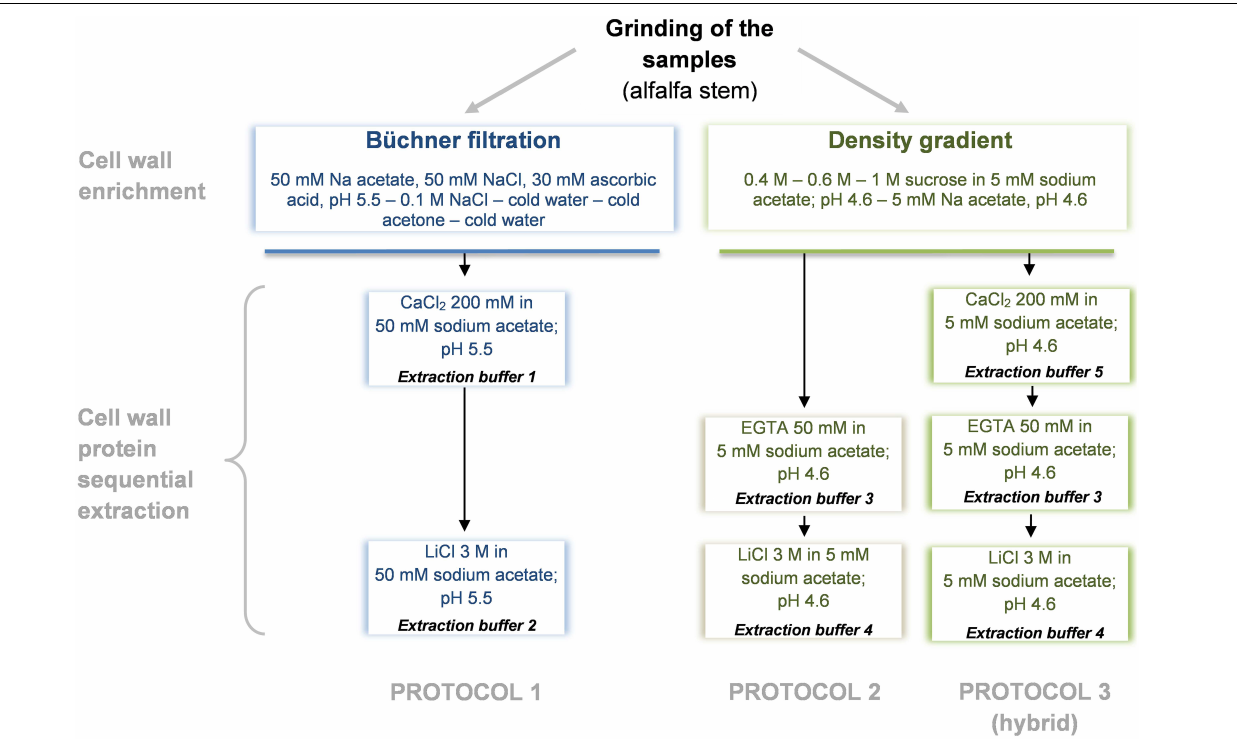
FIGURE 1 | Diagram overview of the cell wall protein extraction protocols. Protocol 1, adapted from Watson et al. (2004); Protocol 2, adapted from Verdonk et al. (2012) ; Protocol 3 (hybrid), adapted from Verdonk et al. (2012) and Feiz et al.